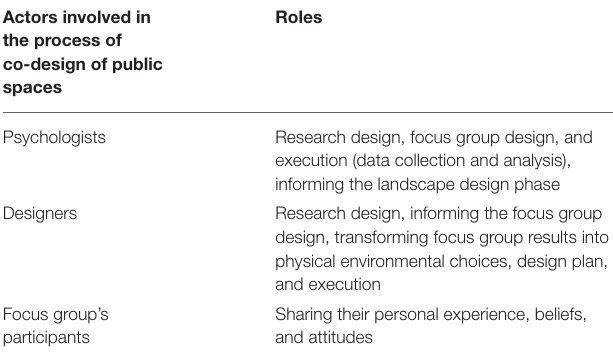
TABLE 1 | Actors and roles in the co-design process. Actors involved in the process